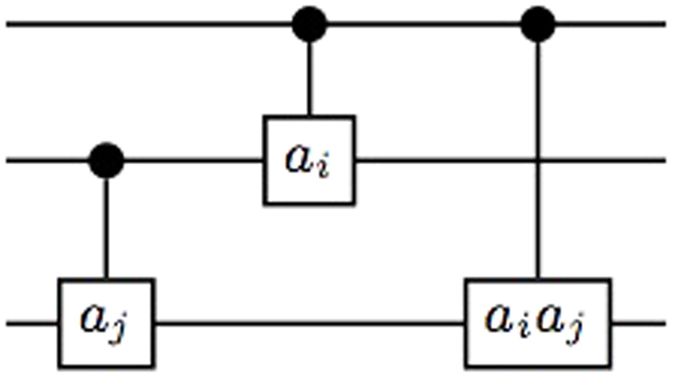
Circuit representation of Eq. (21).